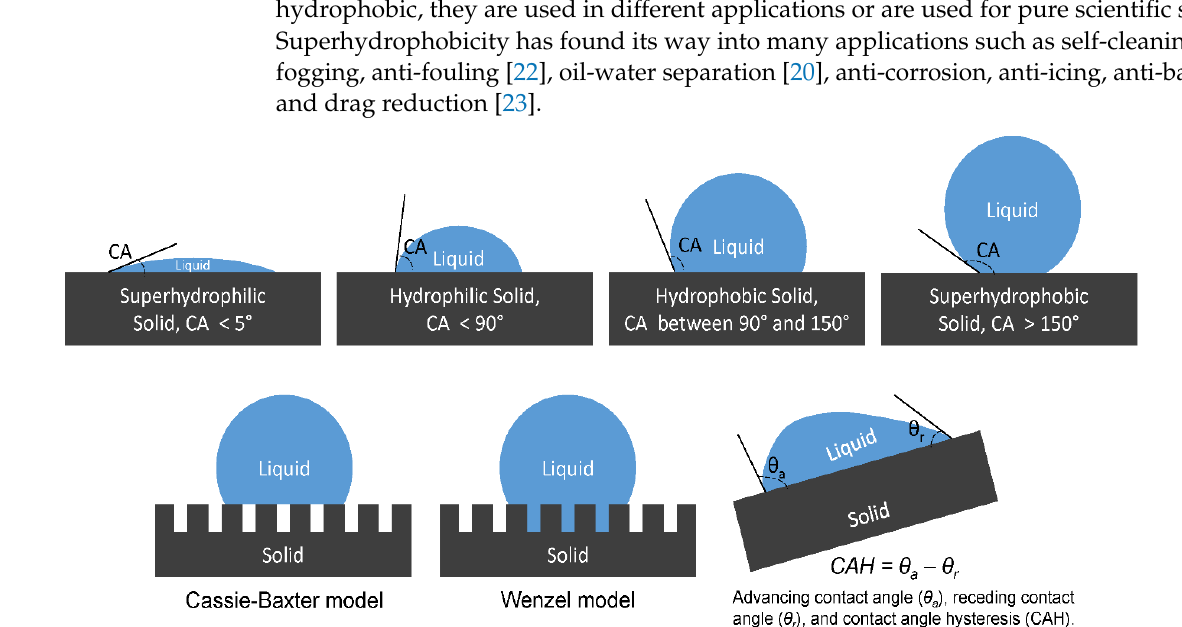
Figure 1. Contact angle, hydrophobicity, the Cassie–Baxter model, and the Wenzel model [17,18].